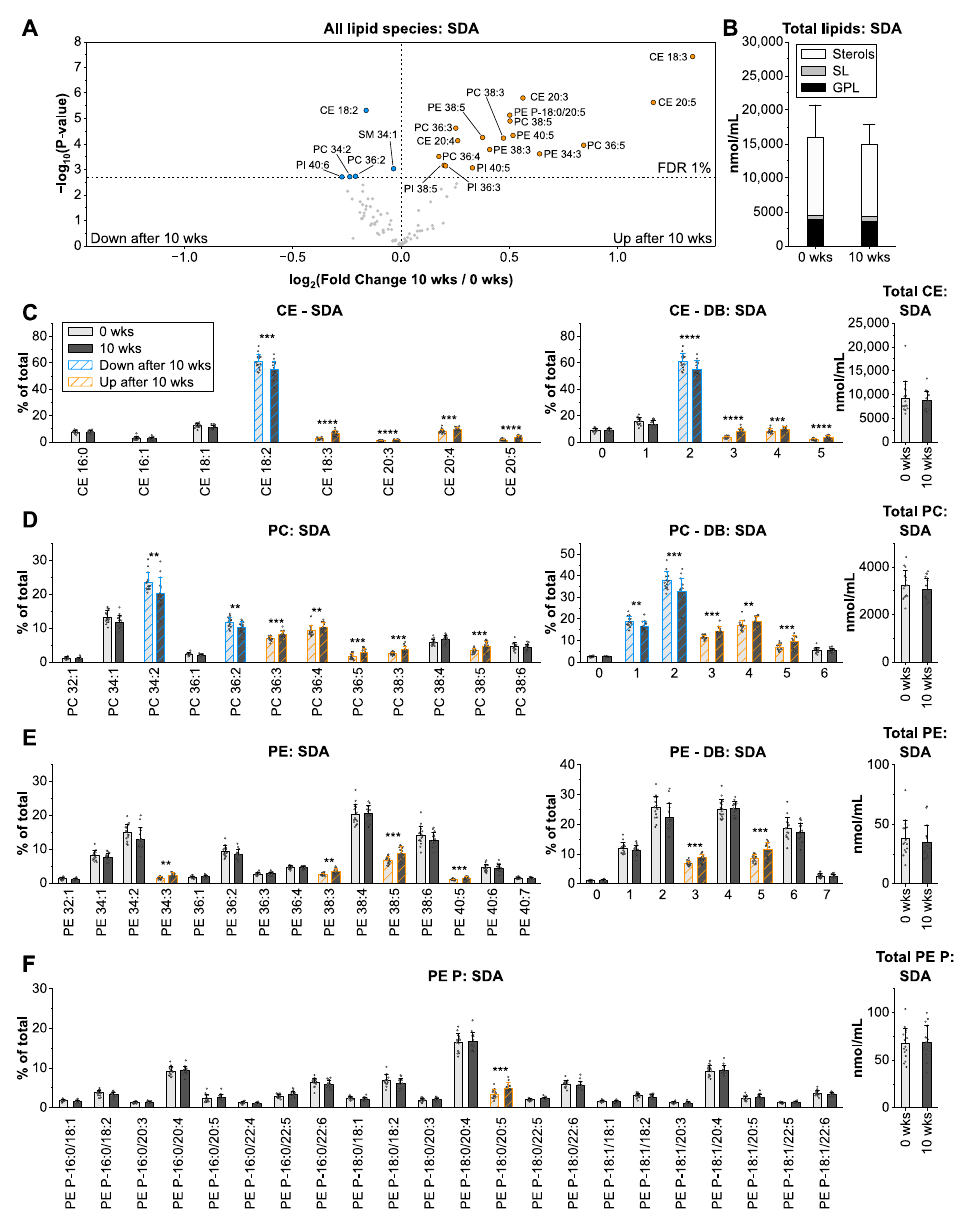
Figure 4. Impact of echium oil intervention on the human plasma lipidome. The arrangement of panels ( A – F ) is identical to Figure 2. Shown are means ± SD of lipid species with an average contribution > 1% from n = 15. ** p < 0.01, *** p < 0.001, **** p < 0.0001.